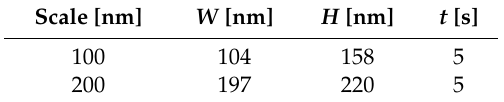
Figure 10. Water penetration distance with increasing imprint number. Table 1. Values assigned to Equation (5) for water penetration